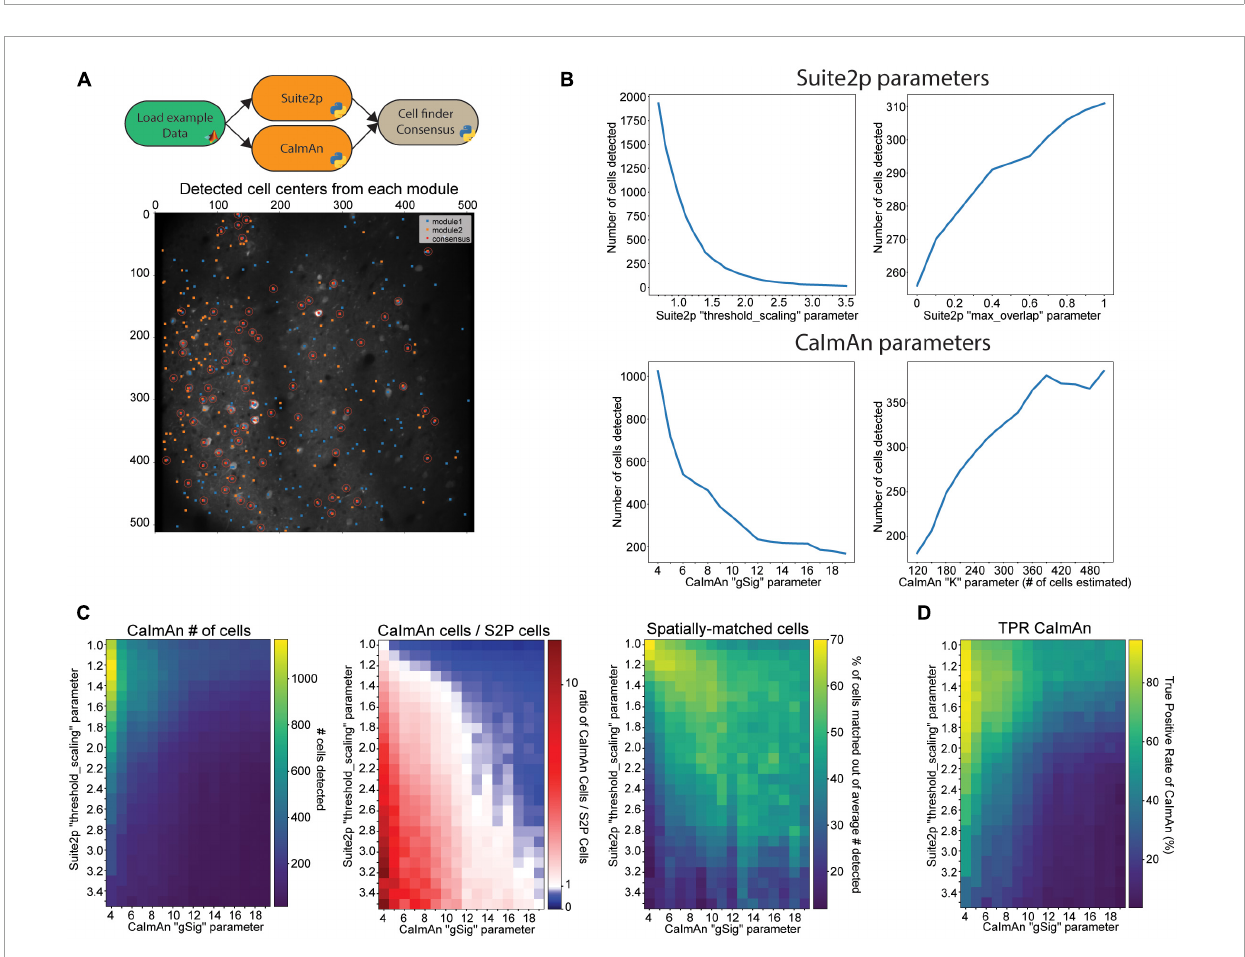
FIGURE3 Results are sensitive to algorithm choice and parameter configuration. (A) Example of the cell detection consensus module in NeuroWRAP. The top schematic illustrates an example usage of the cell segmentation consensus module. The lower image is example output of the consensus module using Suite2p and CaIman on publicly available Neurofinder data. (B) Number of cells detected by Suite2p and CaImAn while altering certain input parameters. Top left : “threshold_scaling,” top right : “max_overlap” (Suite2p), bottom left : “gSig” (CaImAn), bottom right : number of expected cells in field of view extrapolated from “K” (CaImAn). (C) Left : Number of cells detected by CaImAn across a selected parameter space. Middle : Ratio of detected cells in CaImAn to Suite2p across a selected parameter space. White pixels indicate parameter configurations where roughly the same number of neurons were detected. Right : Percentage of cells that were spatially matched between Suite2p and CaImAn at various parameter configurations. (D) Cell-location consensus between ground truth data and CaImAn’s detected cells across a selected parameter